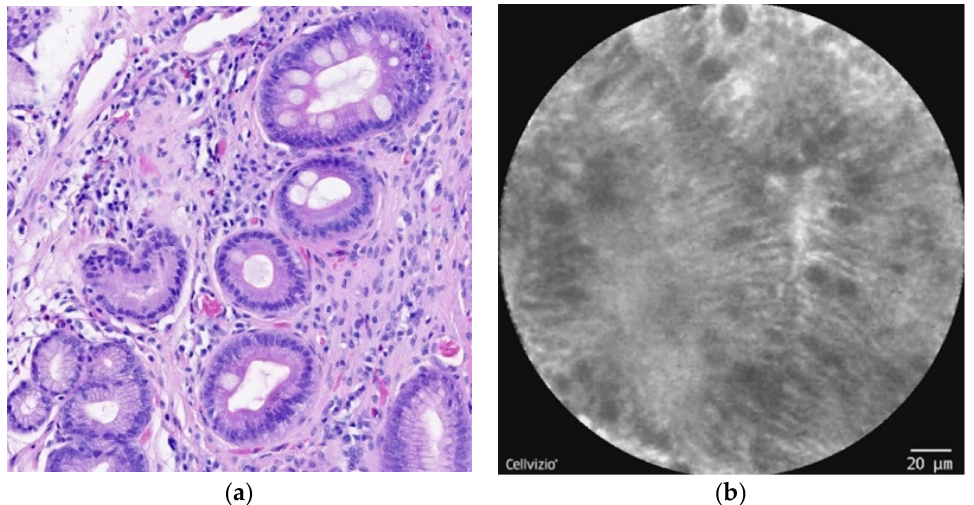
( b ) Figure 3. (a) Endoscopic view of the long segment of BE. ( b ) Endoscopic view of nondysplastic BE investigated with pCLE. The probe attached to the mucosa can be seen.